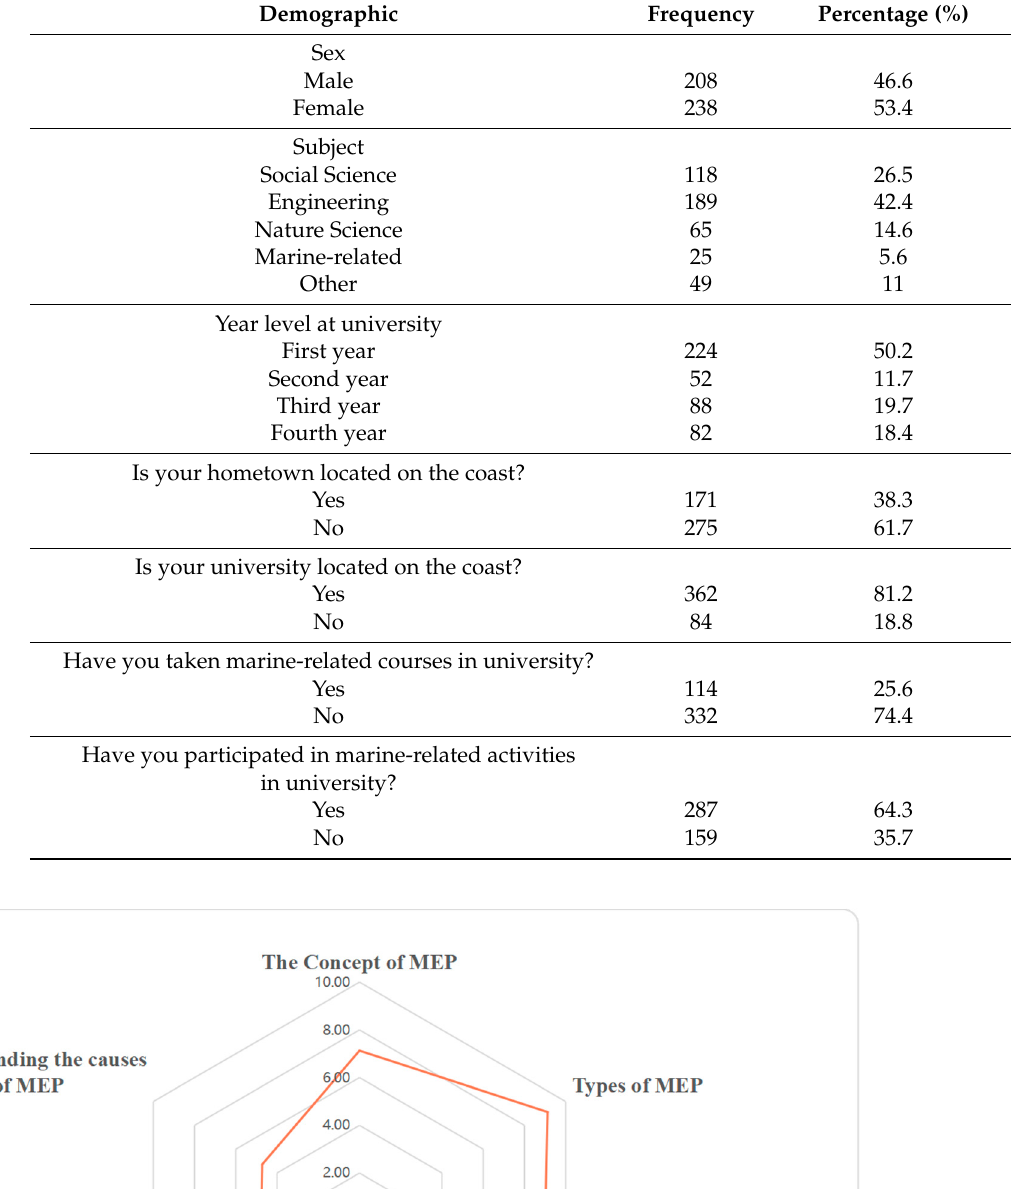
Table 1. Demographic characteristics of participants.